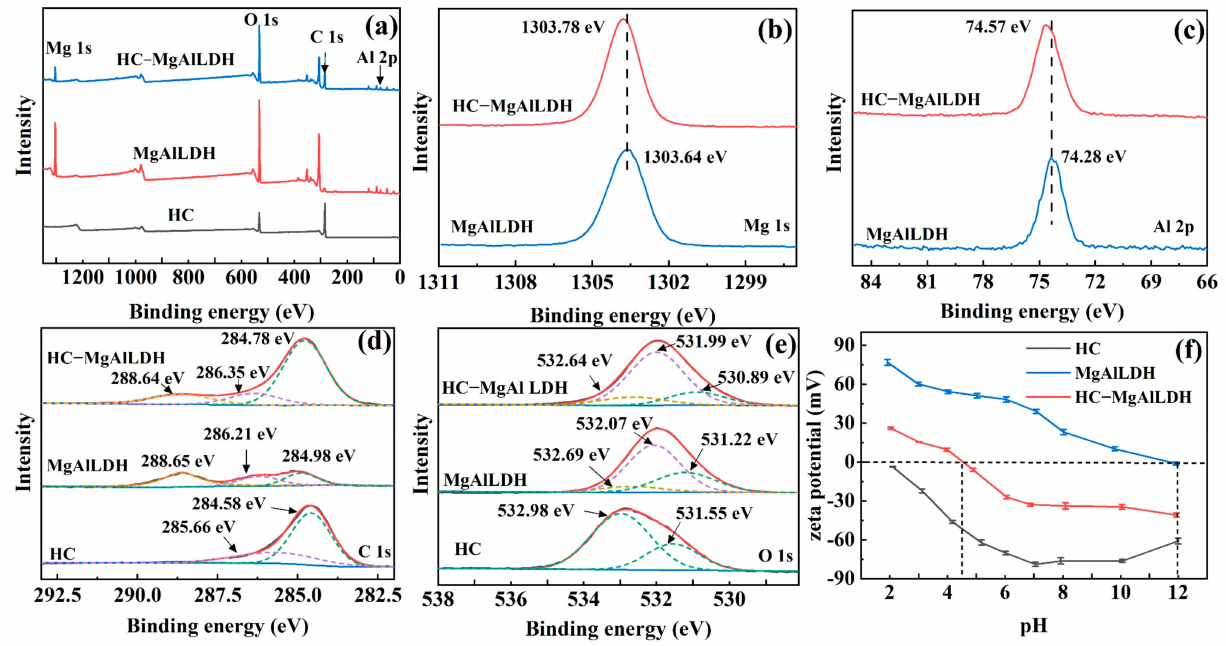
Figure 2. XPS spectra and zeta potentials of the synthesized HC, MgAlLDH and/or HC–MgAlLDH: XPS survey spectra ( a ); high-resolution Mg 1s ( b ), Al 2p ( c ), C 1s ( d ) and O 1s ( e ) XPS spectra; zeta potentials ( f ).